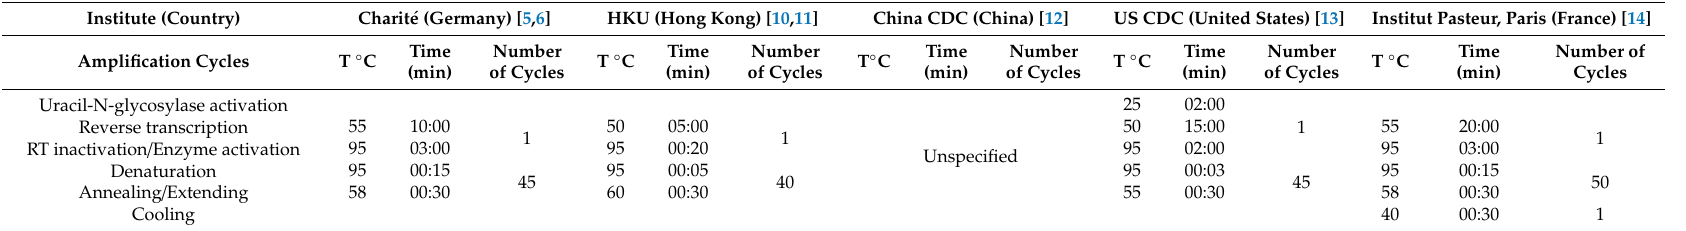
Table 2. Amplification cycles of the five RT-PCR assays targeting